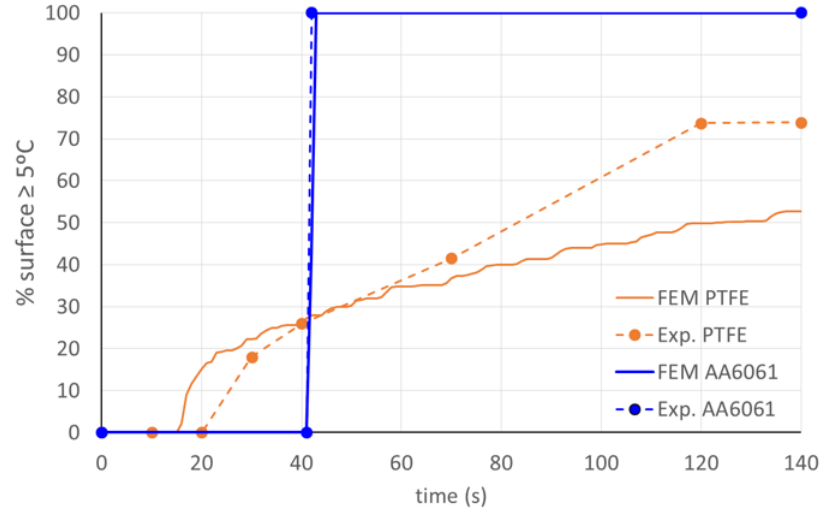
Figure 8. Comparison between modeled and experimental surface ratio above 5 °C.